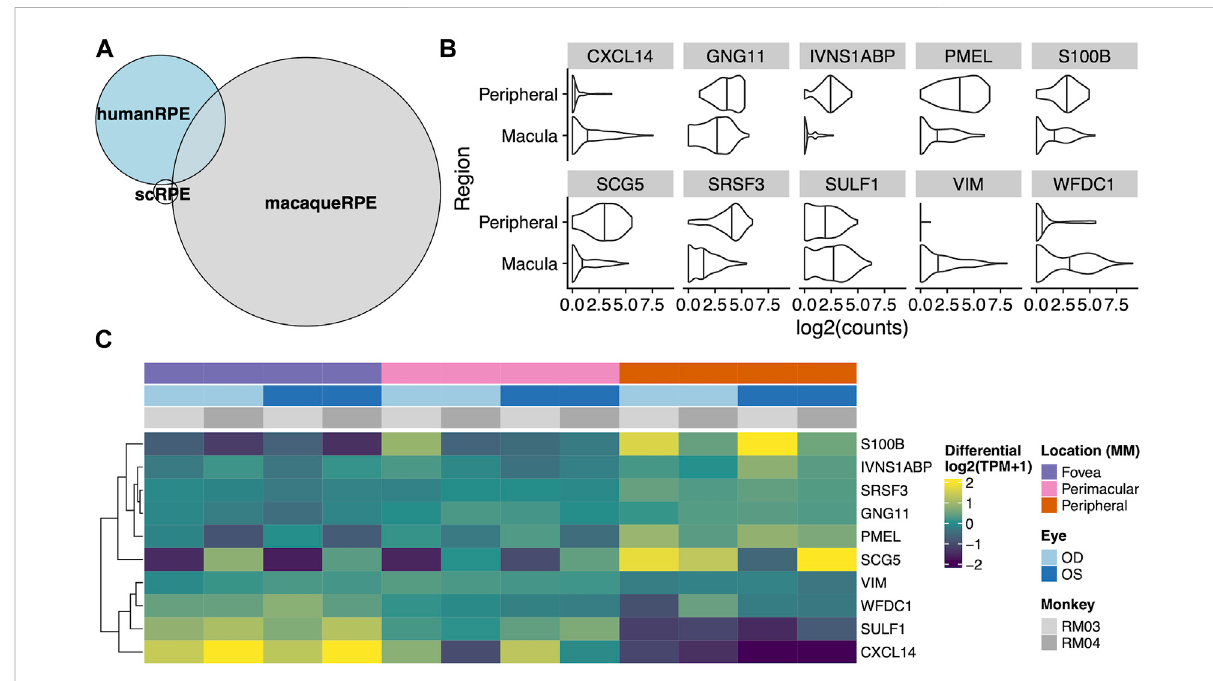
FIGURE 4 (A) Venn diagramofoverlaps betweendifferentially expressed genesbetweenthefovea andperipheryinthree systems:Human single cellRPE, bulk human RPE-choroid,and bulk macaqueRPE-choroid. (B) Violinplotof thesingle cell expressionwith thetengeneswhichoverlap between the human single cell RPE testing and bulk macaque RPE-choroid testing. (C) Heatmap of the same ten genes in our macaque RPE-choroid